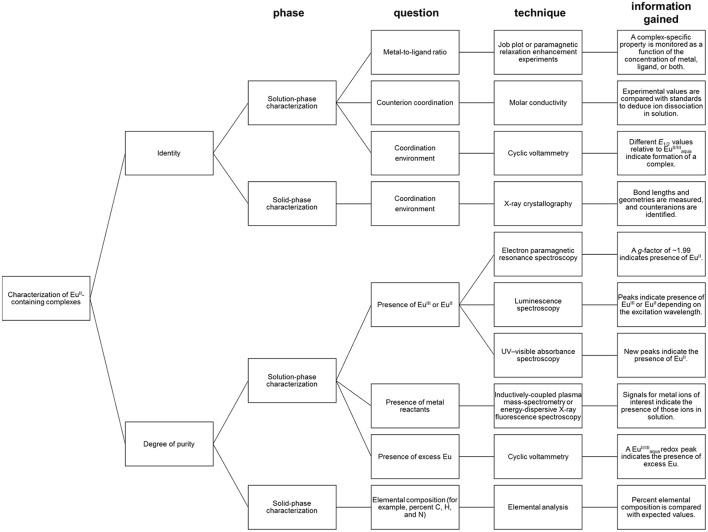
Diagram for the characterization of EuII-containing complexes.